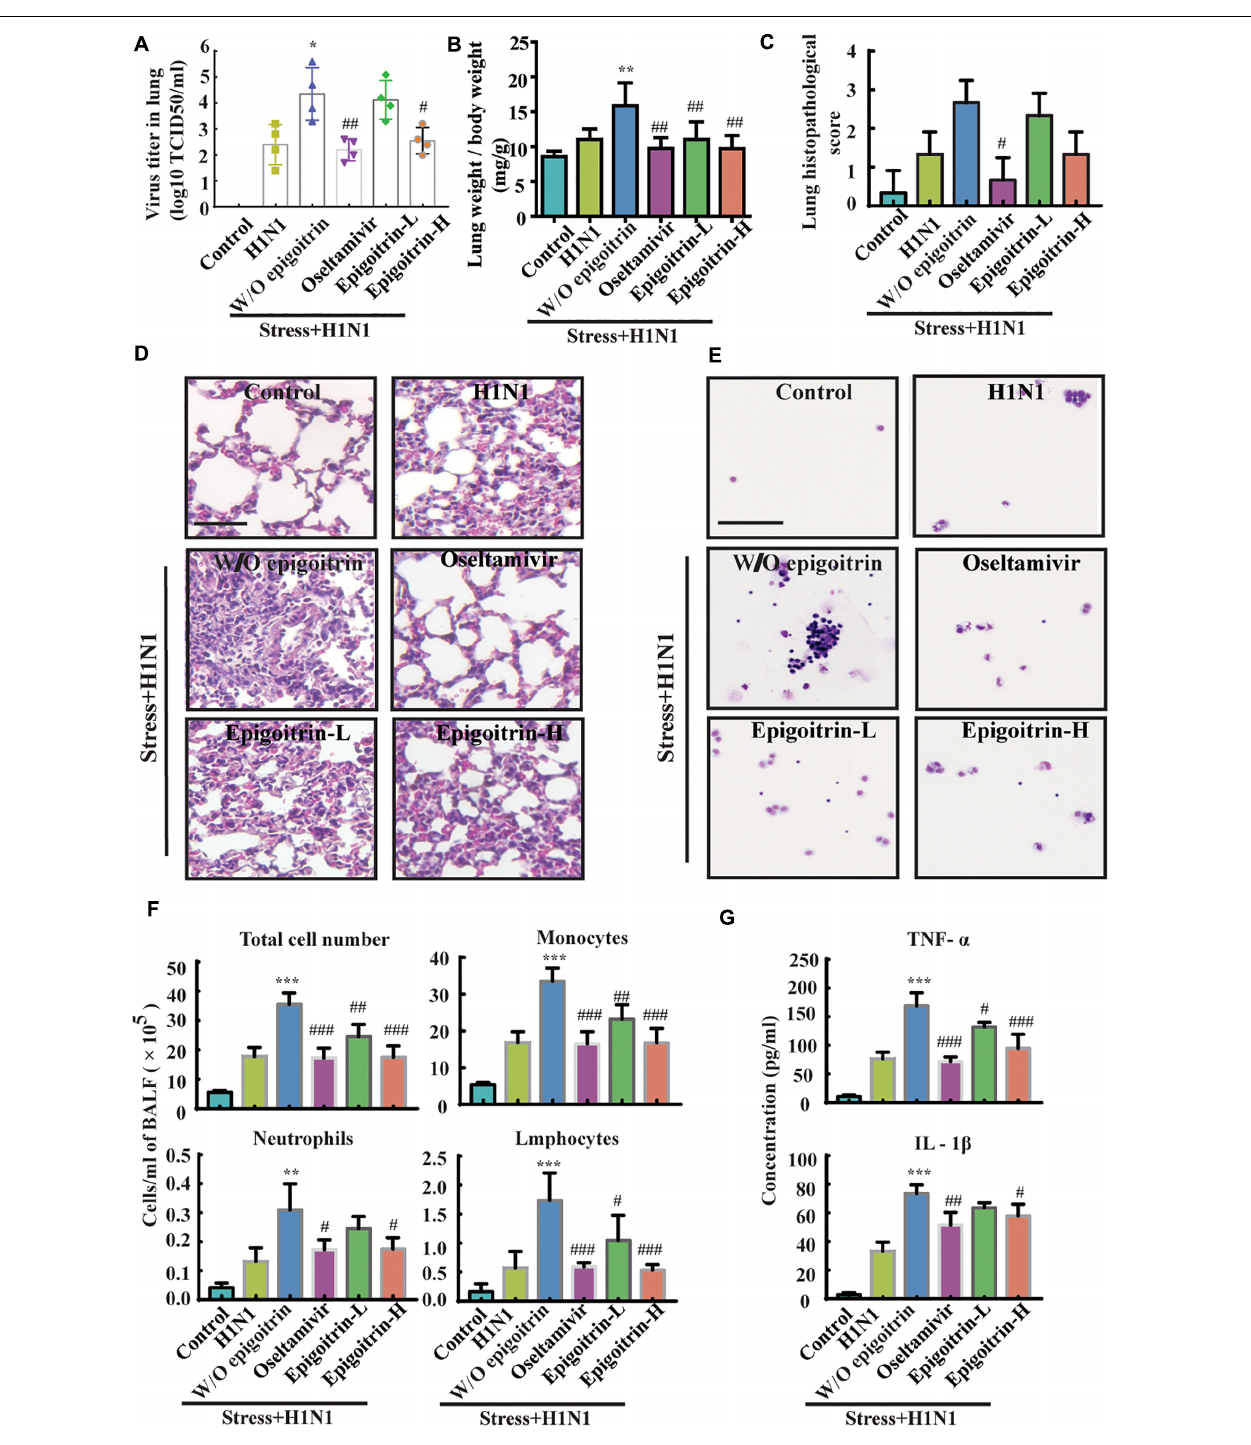
FIGURE 2 | Epigoitrin protected against pneumonia caused by influenza infection in stressed mice. (A,B) The effects of epigoitrin on the viral titres in the lungs ( n = 4) and the lung index ( n = 6). (C,D) Lung pathological scores ( n = 3) and histopathologic changes on the 5th day after influenza virus challenge, stained by H&E (scale bar = 50 µ m). (E,F) Effects of epigoitrin on the changes of types of infiltrated inflammatory cells and cell numbers in BALF (scale bar = 100 µ m). (G) Effects of epigoitrin on the levels of TNF- α , IL-1 β in BALF ( n = 4). The difference was considered statistically significant at ∗ P < 0.05, ∗∗ P < 0.01, ∗∗∗ P < 0.001 vs. H1N1 group; # P < 0.05, ## P < 0.01, ### P < 0.001 vs. “Stress+H1N1”